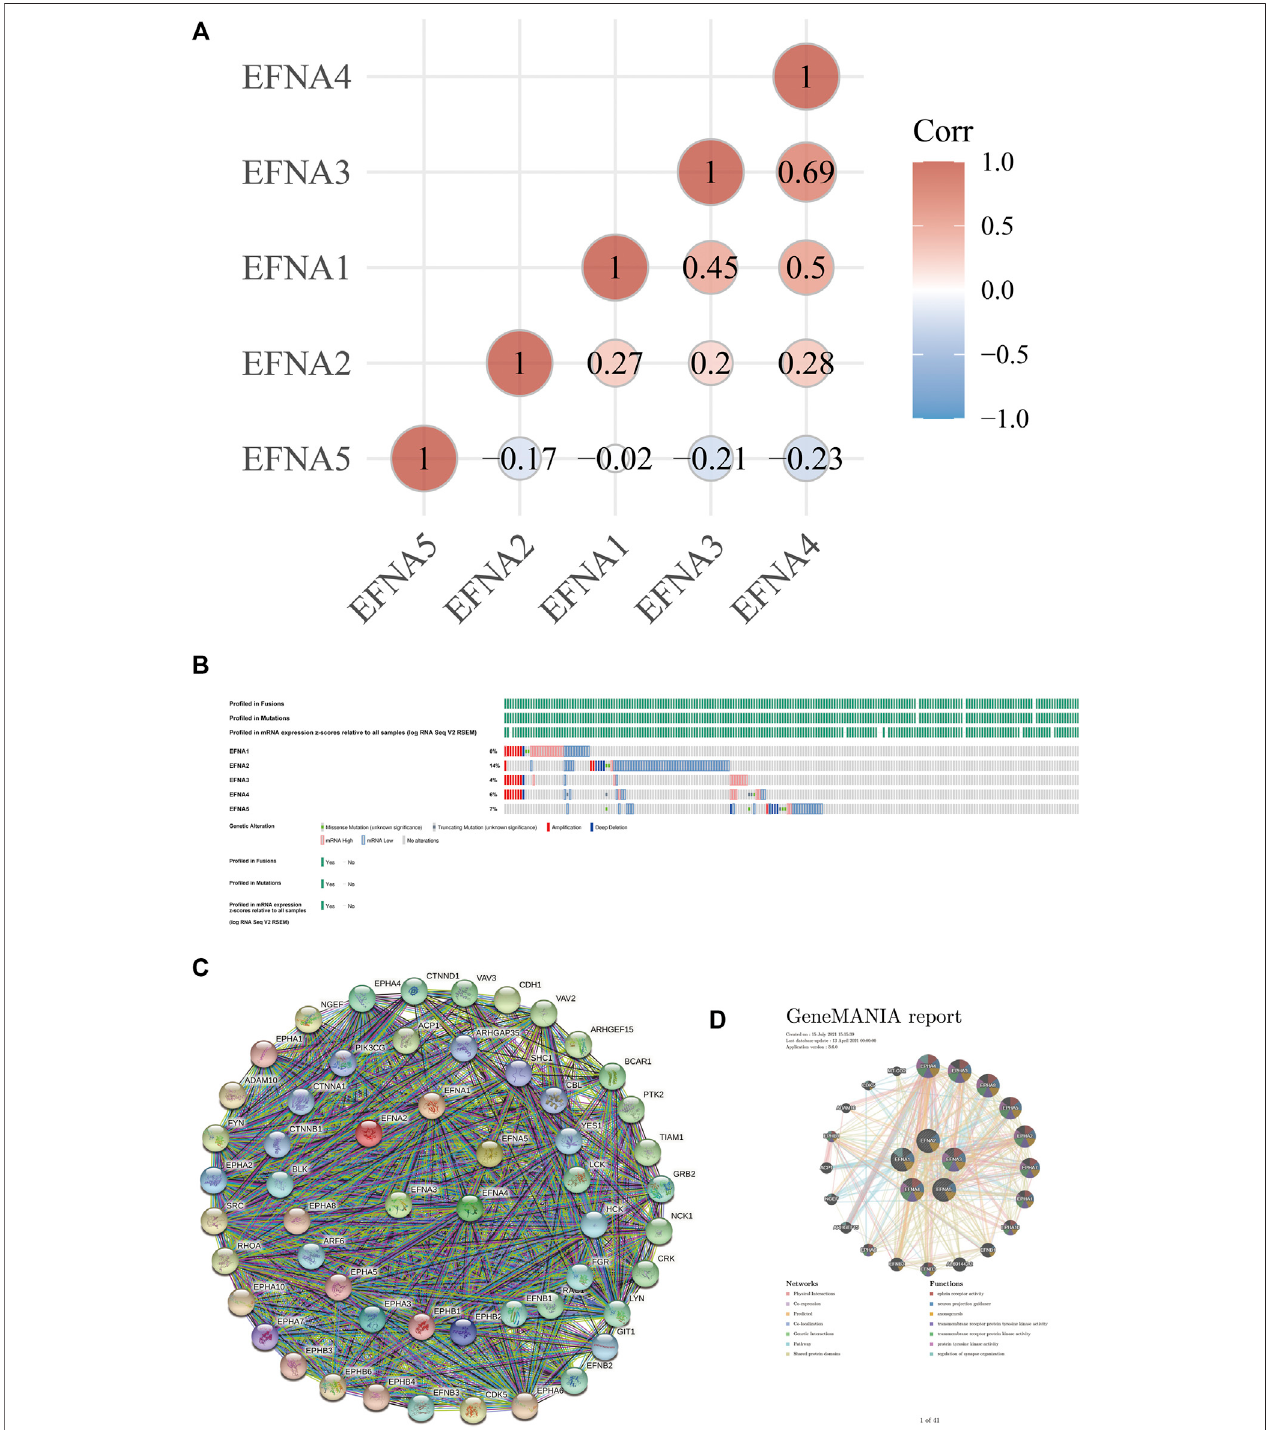
FIGURE 4 | Correlation analysis of EFNA genes in gastric cancer, gene changes and protein interactions. (A) Correlation of different genes in between different EFNAgenesingastric cancer. (B) Typesand proportionsofEFNAgene changesingastriccancer samples. (C,D) Proteininteractionnetworkofdifferent genesinEFNA involved with different EFNA genes.